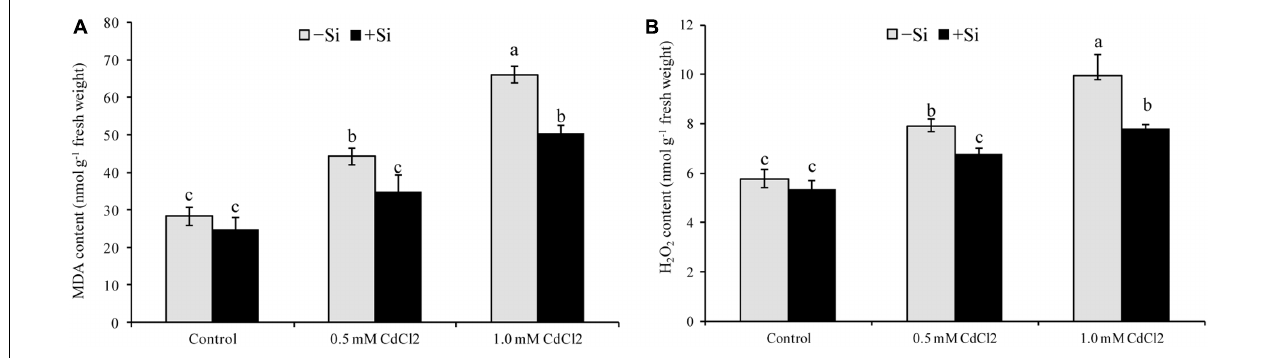
FIGURE 1 | Silicon-induced changes in oxidative stress markers (MDA, A and H 2 O 2 , B content) in Brassica napus seedlings grown under Cd stress. Values (Mean ± SD) of each treatment are obtained from three replications. Bars with different letters are significantly different at P < 0.05 applying Tukey’s HSD